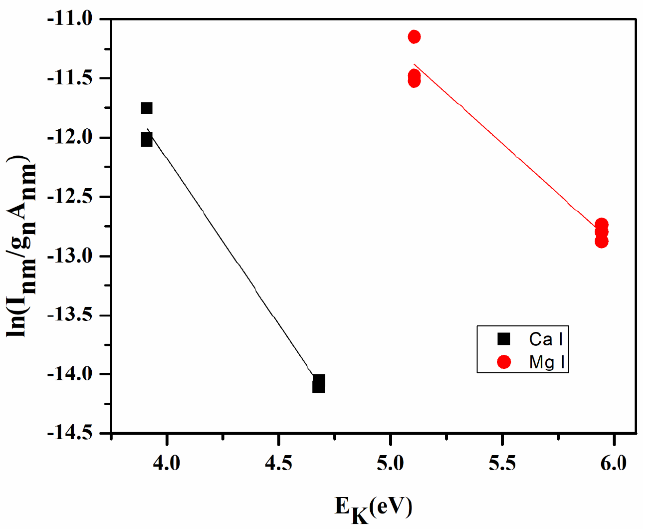
where N e is the electron density, T is the temperature in Kelvin, and ∆ E is the maximum energy difference between two states of an atom.